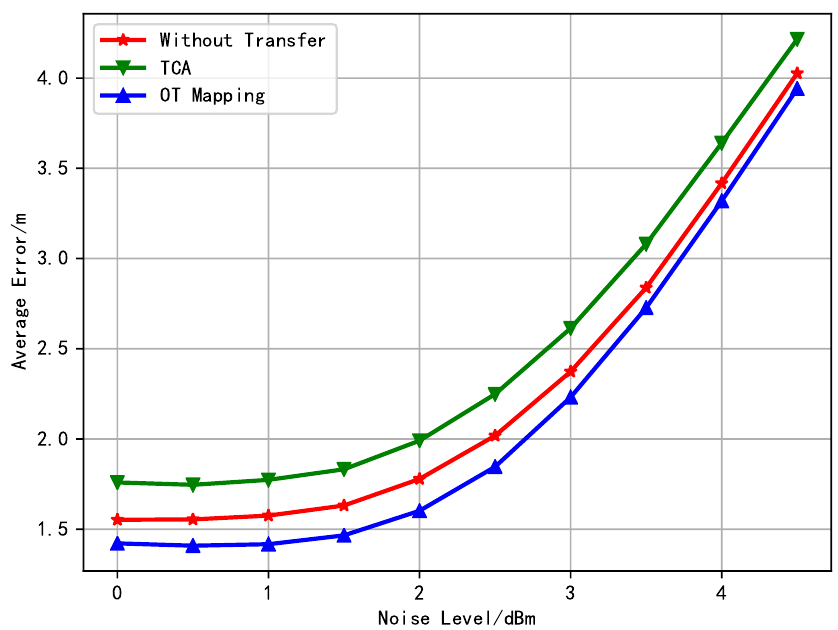
Figure 9. Comparison of the average positioning error of the transfer learning algorithms (using multi-wall